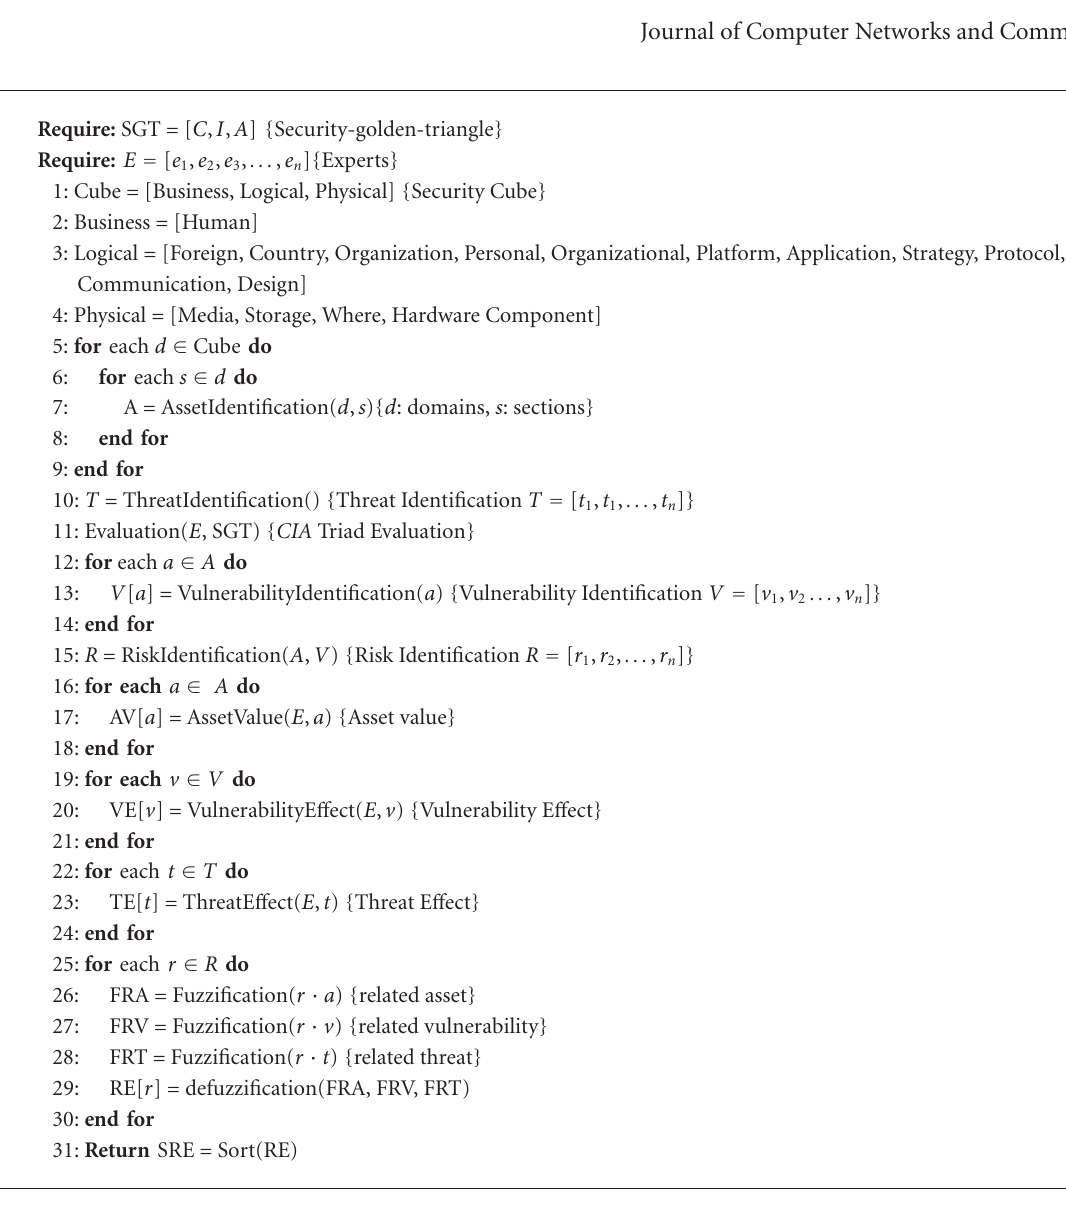
Algorithm 1: Risk assessment (). Table 1: Workflow